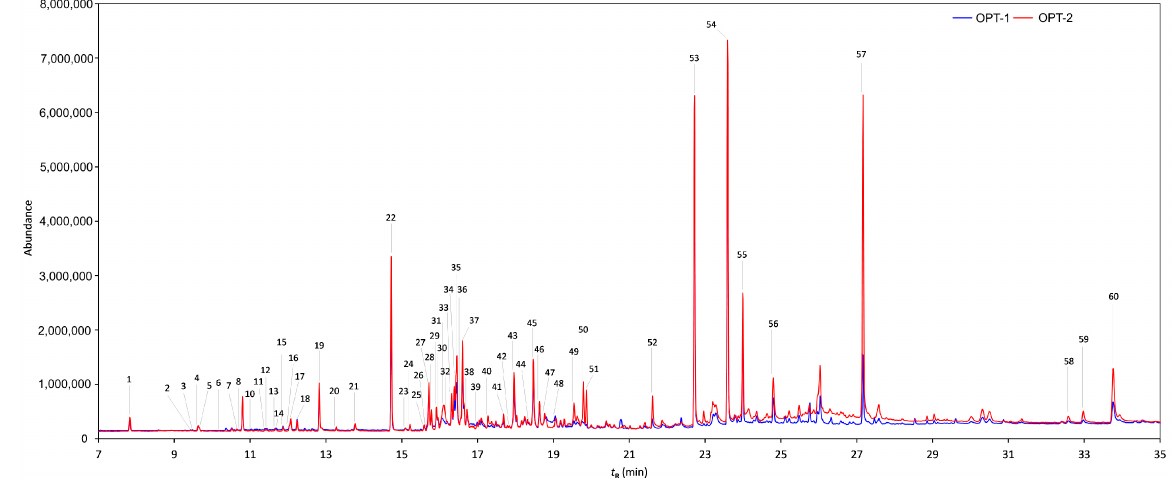
Figure 2. GC-MS chromatograms of the OPT-1 (blue line) and OPT-2 (red line) extracts (prepared as described in Section 2.6). The tentative identification is as follows: 1 = α -pinene, 2 = α -terpinene, 3 = p-cymene, 4 = eucalyptol, 5 = D -limonene, 6 = γ -terpinene, 7 = cyclooctanone, 8 = α -terpinolene,